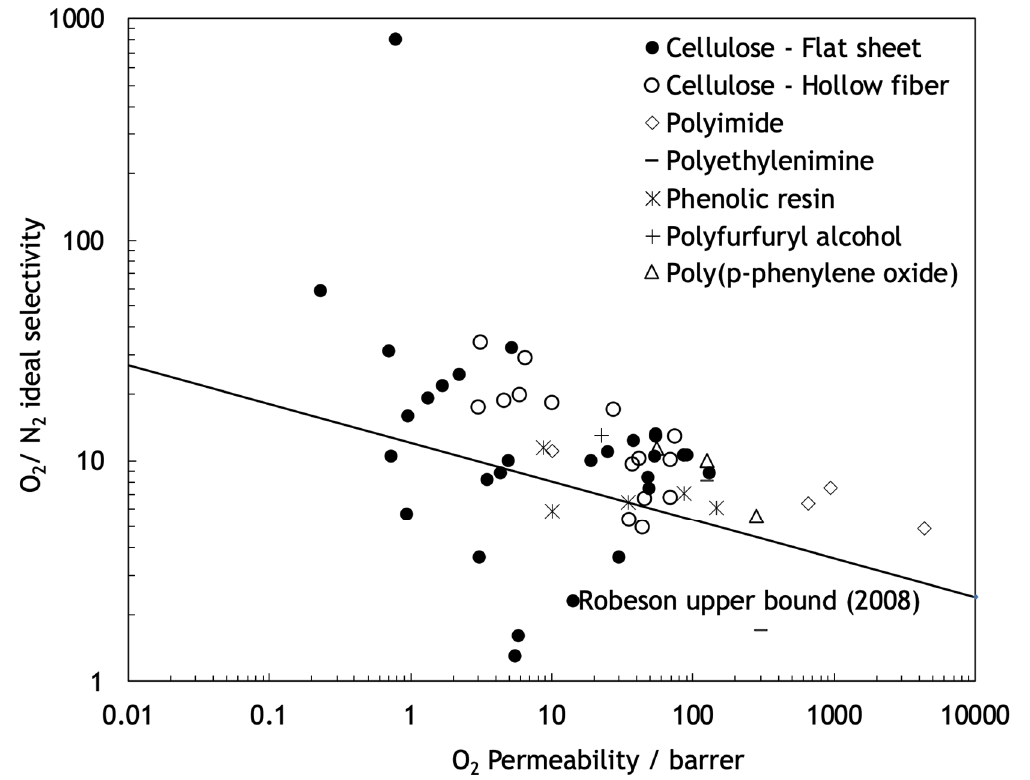
Figure 11. Separation performance of CMSM with different polymeric precursors for O 2 /N 2 separation.